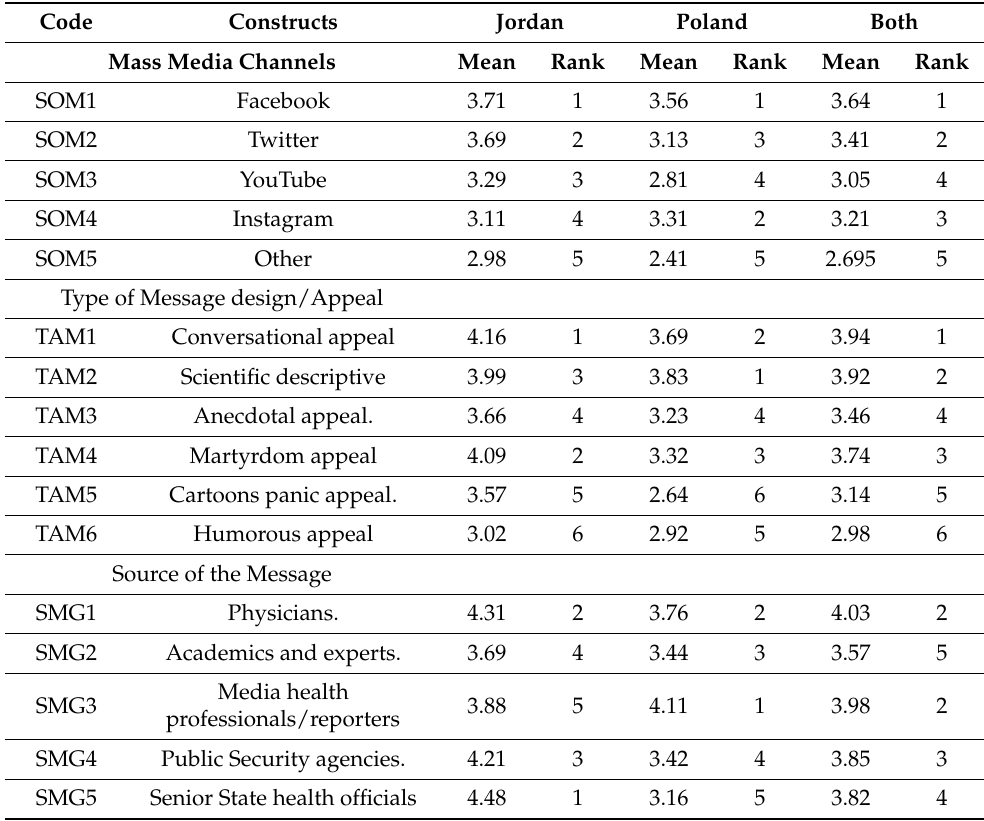
Table 3. The mean and standard deviation of the study